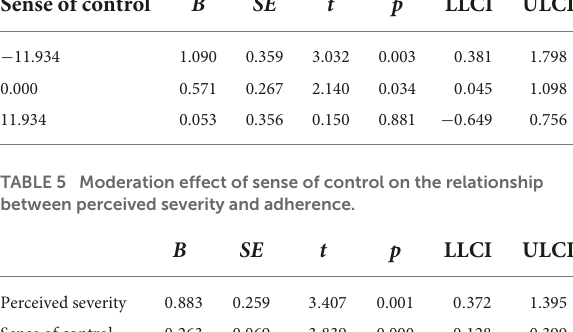
Another multiple regression analysis was conducted to determine whether sense of control moderated the relationship between perceived severity and adherence to prevention guidelines (see Table 5 ). The model containing perceived severity, sense of control, and adherence behavior was